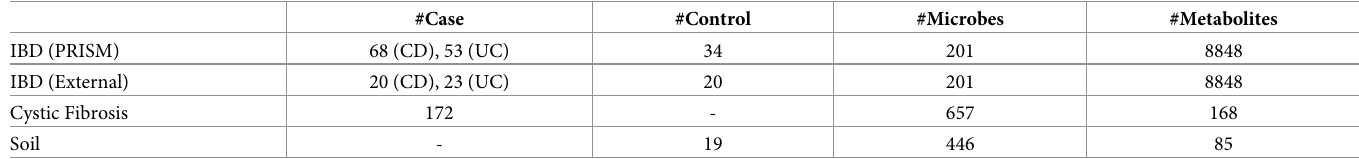
Table 1. Summary of the datasets used in evaluation. The patients with IBD have two subtypes: Crohn’s Disease (CD) and Ulcerative Colitis (UC).